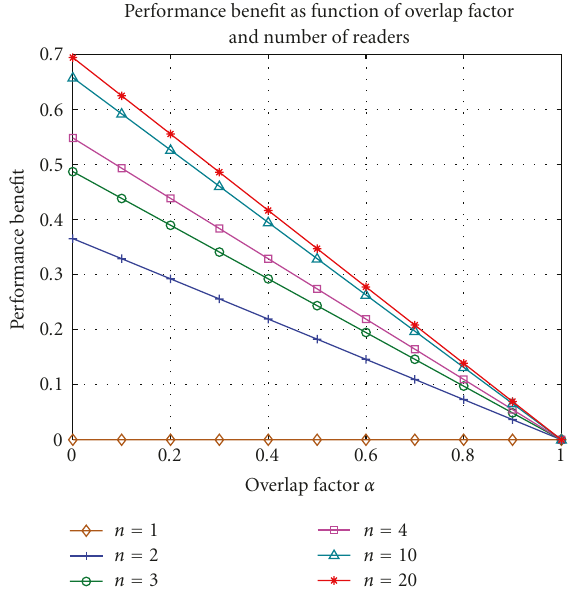
Figure 9: Performance gain through numerical evaluation in terms of decreased tag reading time with BLSync for di ff erent values of n and overlap factor α.